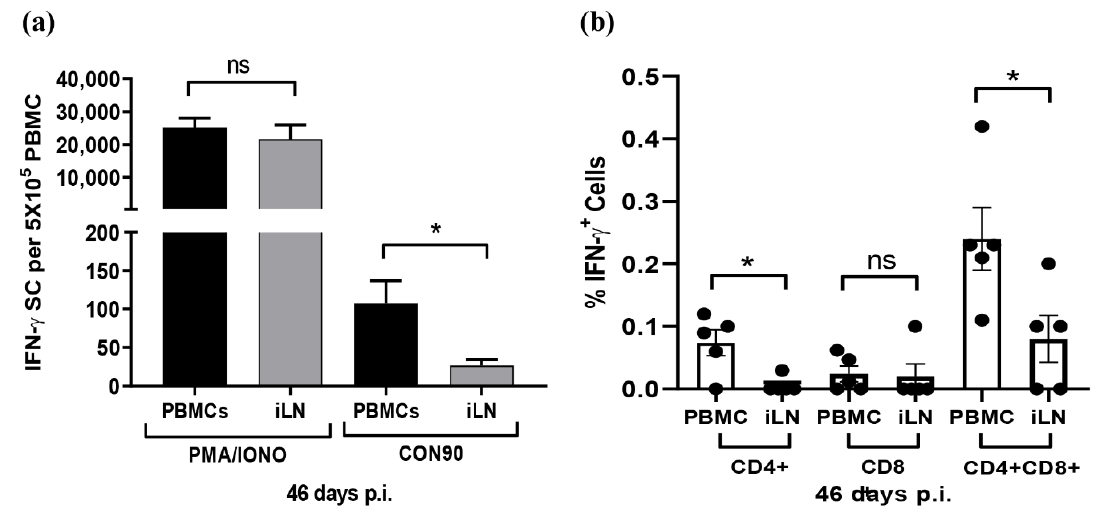
Figure 7. Analysis of IFN-γ secreting cells during persistent PRRSV infection. PBMCs and ILN cells were collected from five pigs that were infected with CON90 at 46 dpi. The cells were stimulated with CON90 as described in the Materials and Methods. For positive control, the cells were stimulated with PMA and ionomycin (PMA/IONO). ( a ) Frequencies of IFN-γ SCs in PBMCs and ILN measured by IFN-γ Elispot. PMA/IONO spots counted as per 5000 cells/well and extrapolated for 5 × 10 5 cells. ( b ) Percentage subset of T cell secreting IFN-γ as measured by flow cytometric analysis. Dataset represents mean ± S.E.M values calculated from five pigs in each treatment group. * p < 0.05.